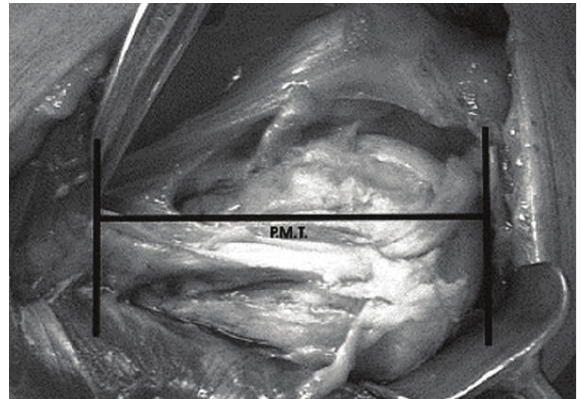
Figure 2: The average distance from the pectoralis major tendon (PMT) insertion to the tangent to the humeral head is 5.6cm. (Reprinted with permission from Murachovsky et al.